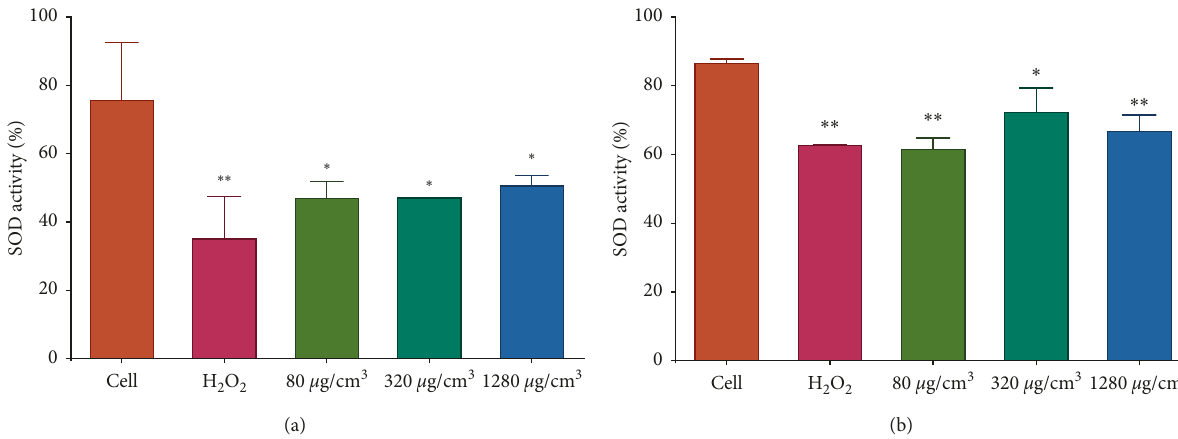
Figure 8: Effect of Pichincha’s volcanic ash on the activity of the superoxide dismutase enzyme (SOD) in (a) A549 and (b) McCoy cell lines at 24 hours after treatment with 80, 320, and 1280 µ g/cm 3 of volcanic